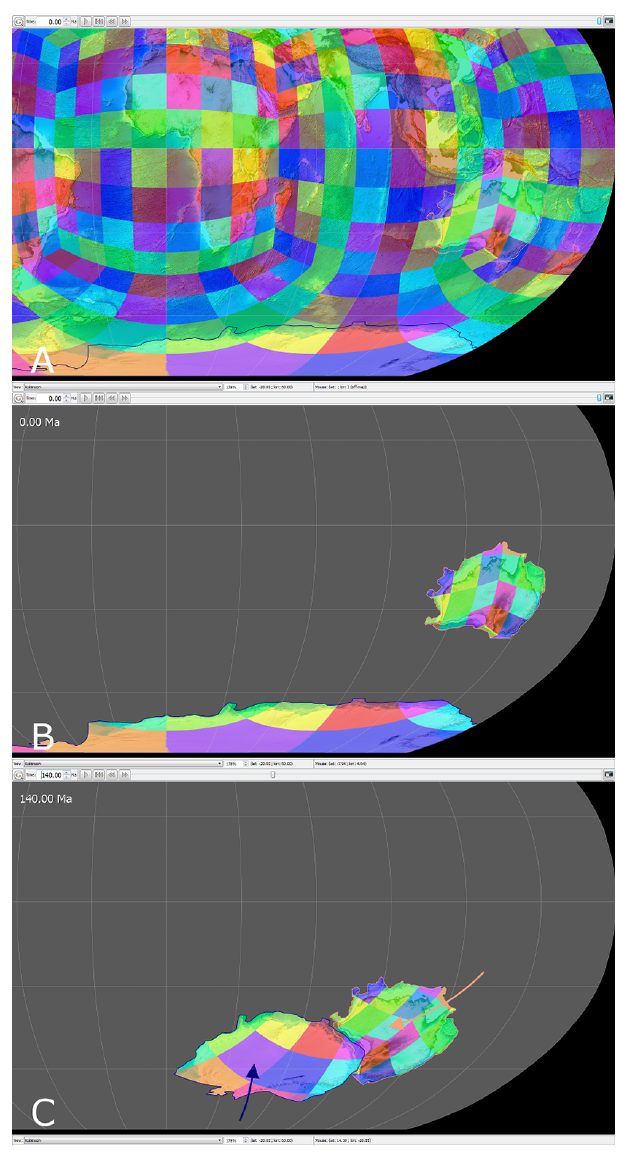
Figure 10. The GPlates “Robinson” 2-D map projection view of the ETOPO1 global raster (Amante and Eakins, 2009), reconstructed to 140Ma for continental Australia and Antarctica. The cube map tiles are highlighted in different colours. This is the equivalent of Fig. 9 but with a 2-D map projection view instead of the 3-D or- thographic view. (A) The entire unreconstructed raster with raster tiles following a cube-like arrangement. (B) The tectonic polygons in their present-day (0Ma) locations. (C) The tectonic polygons in their reconstructed locations at 140Ma. Each plate rotation is illus- trated by a curved